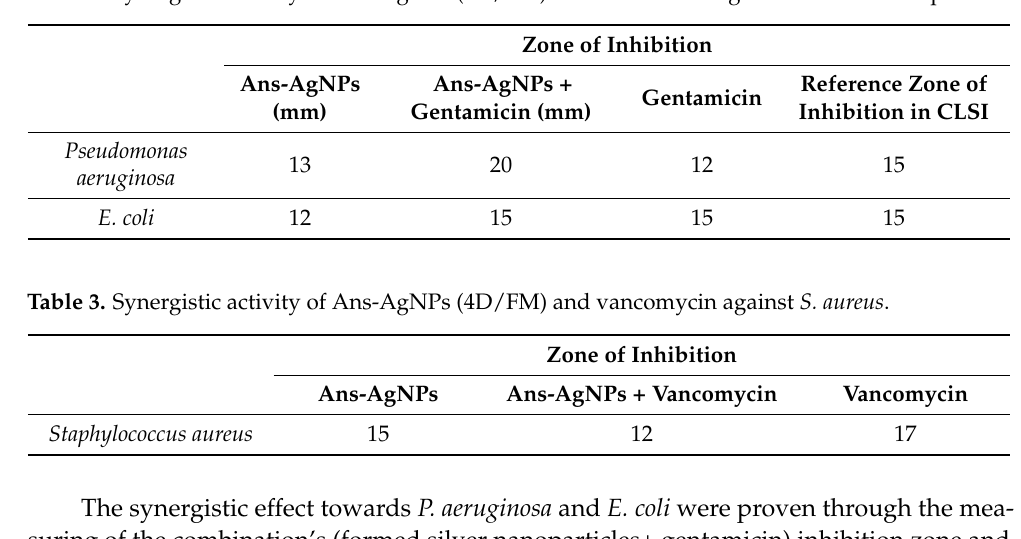
Table 2. Synergistic activity of Ans-AgNPs (4D/FM) and Gentamicin against the bacterial species.